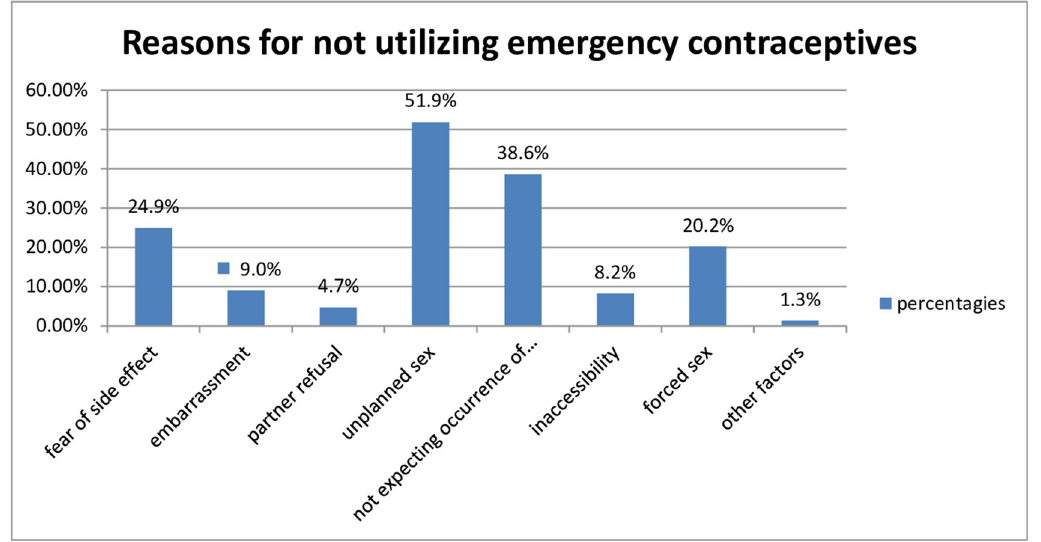
Fig 1. Reasons of not utilizing emergency contraceptives of women seeking termination of pregnancy, Northwest Ethiopia, 2019(n = 319).